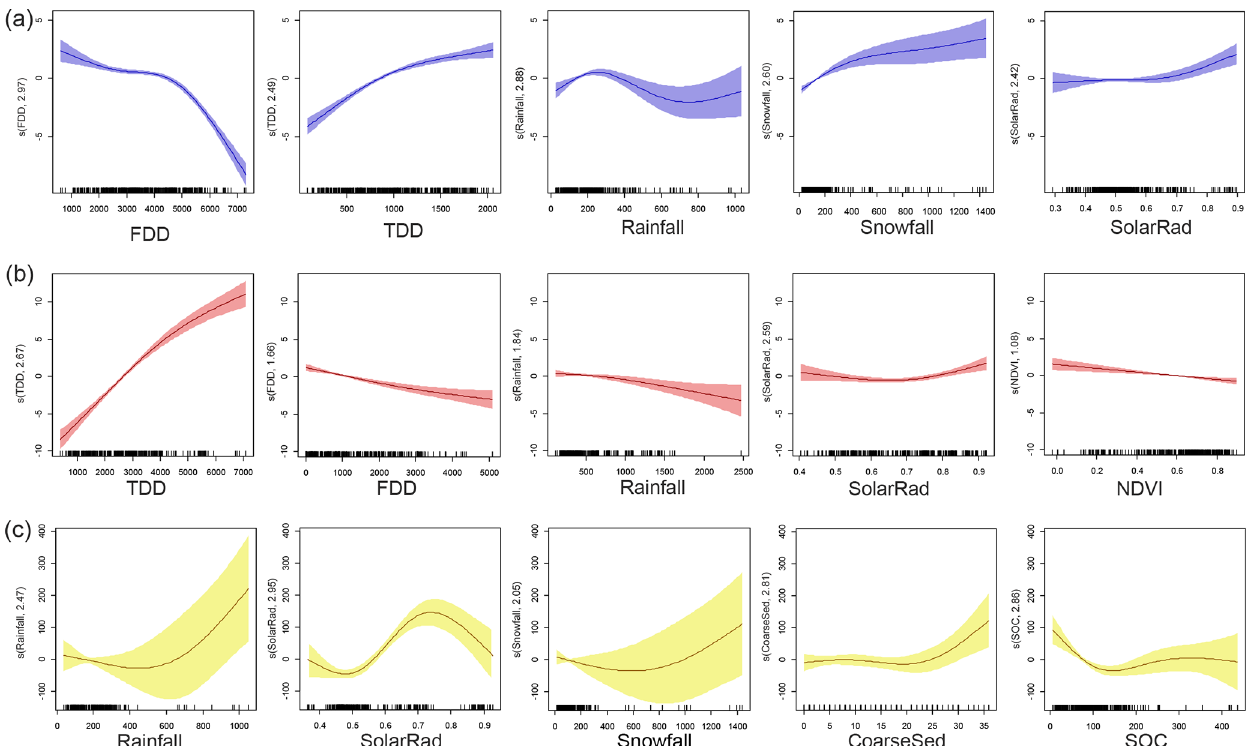
Figure 4. Response shapes of the five predictors with the most contribution in MAGT ≤ 0 ◦ C (mean annual ground temperature less than or equal to 0 ◦ C, blue curves) (a) , MAGT > 0 ◦ C (mean annual ground temperature greater than 0 ◦ C, red curves) (b) and ALT (active-layer thickness, yellow curves) (c) datasets obtained from generalized additive modelling (GAM). Response shapes for the remaining predictors are illustrated in Fig. S2. Predictors (see Sect. 2.2 for abbreviations) are presented in descending order of their effect size in the respective datasets. The x axis units appear in the original scale of the predictors. The y axis displays partial residuals and labels the estimated degrees of freedom used in fitting the respective predictors to a response. Shaded areas depict 95% confidence